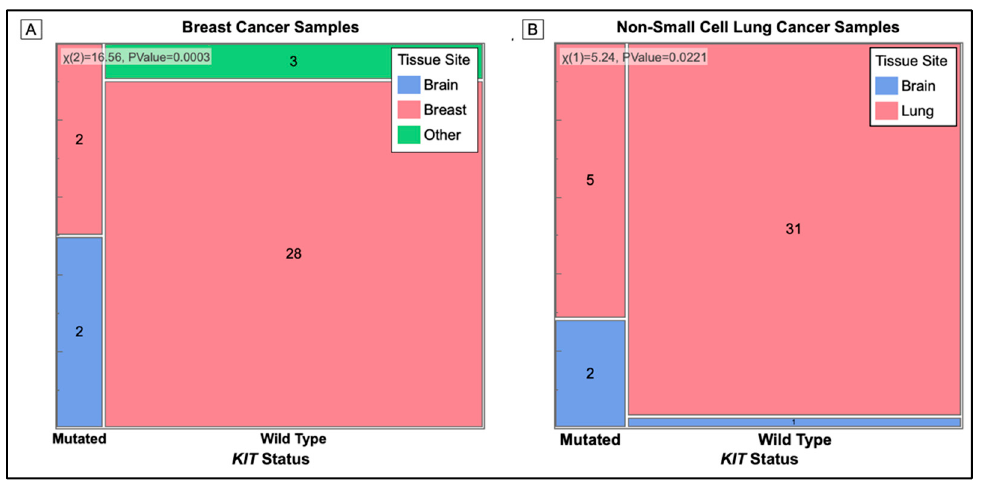
Figure 4. Comparison of Serum Galectin Levels of Non-small Cell Lung Cancer Patients with KIT and PTEN Mutations in Tumor Sample. ( A ) Serum levels of galectin-1, as determined by ELISA, were significantly higher in non-small cell lung cancer patients with a mutation in the KIT gene. ( B , C ) Serum levels of galectins -1, and -7 were elevated in patients with a mutation in the PTEN gene. (* p -value ≤ 0.05, ** ≤ 0.01).